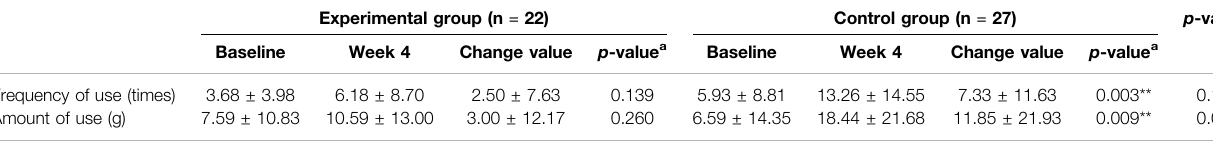
TABLE 4 | Changes in the amount and frequency of ointment use.